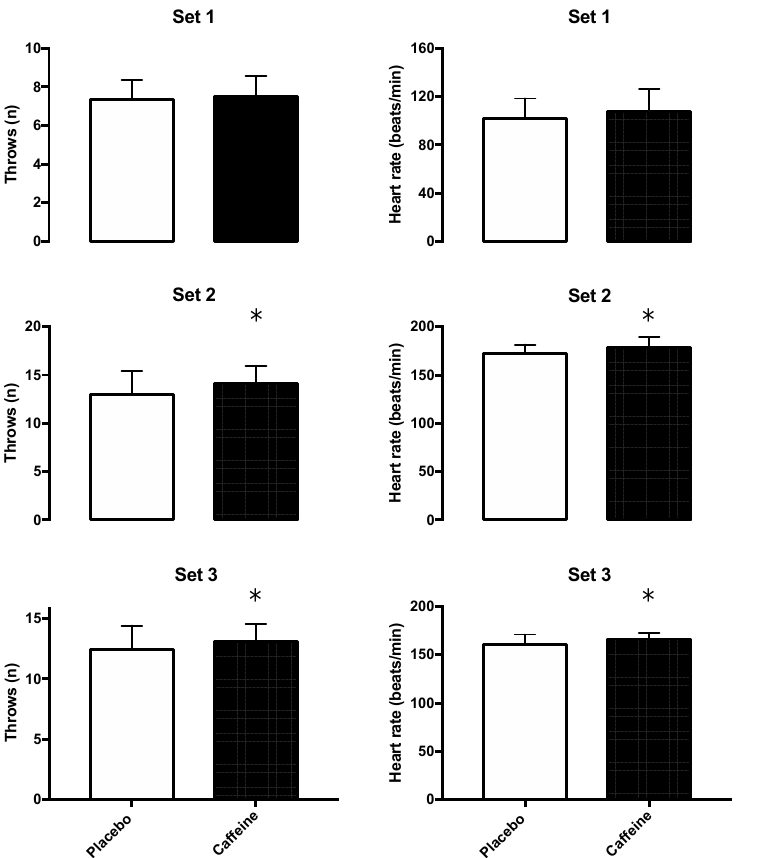
Figure 2. Number of throws and heart rates during the different series in the SJFT test after the administration of 3 mg/kg body mass caffeine and placebo. Data are shown as mean ± SD for 22 athletes. (*) Caffeine is significantly different from the placebo condition ( p < 0.05). Left graphs show the number of throws, and right graphs show the average heart rate (bpm). White columns are placebo conditions, and black columns are caffeine conditions. Table 1. Total number of throws, work index, heart rate and perceptual variables obtained after the SJFT test with the administration of 3 mg/kg body mass of caffeine and